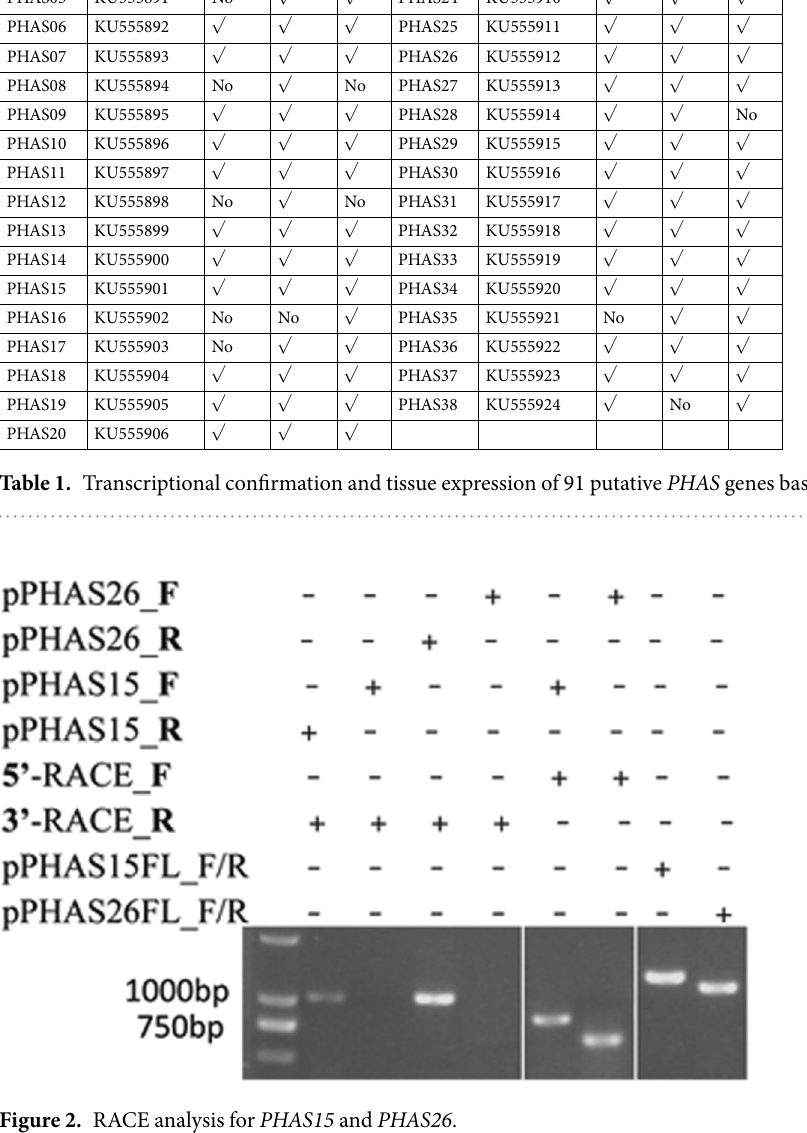
demonstrating that the identified phasiRNAs are indeed generated from the respective PHAS loci (Fig. 3B and C). These results confirmed the PHAS identification from the PhaseTank pipeline. Identification of B. cinerea -responsive phasiRNAs and experimental evidence. As indicated above, 31 of the identified PHAS loci mapped to the coding regions of genes encoding disease resistance-related proteins, suggesting that phasiRNA could be responsive to disease infection. To investigate phasiRNAs responsive to B. cinerea in tomato, reads from two small RNA libraries of tomato leaves inoculated with B. cinerea (infected and control) were analyzed. A total of 245 phasiRNAs with relatively high expression were subjected to further analysis. Among these 245 phasiRNAs, 50 from 27 loci hand increased abundance and five phasiRNAs from five loci had decreased abundance in B. cinerea -infected leaves (Table S4). To validate these 55 B. cinerea -responsive phasiRNAs, sRNA-seq data from B. cinerea -inoculated tomato leaves at three time points (0 h, 24 h, and 72 h) were used 25 . Twenty-nine phasiRNAs were confirmed, including 27 phasiRNAs with increased abundance and two with decreased abundance, and the expression patterns were consistent with our sRNA-seq data. Another eight phasiRNAs also had altered expression in B. cinerea -infected leaves, but an opposite change in expression patterns was observed. Among the remaining 18 phasiRNAs, no